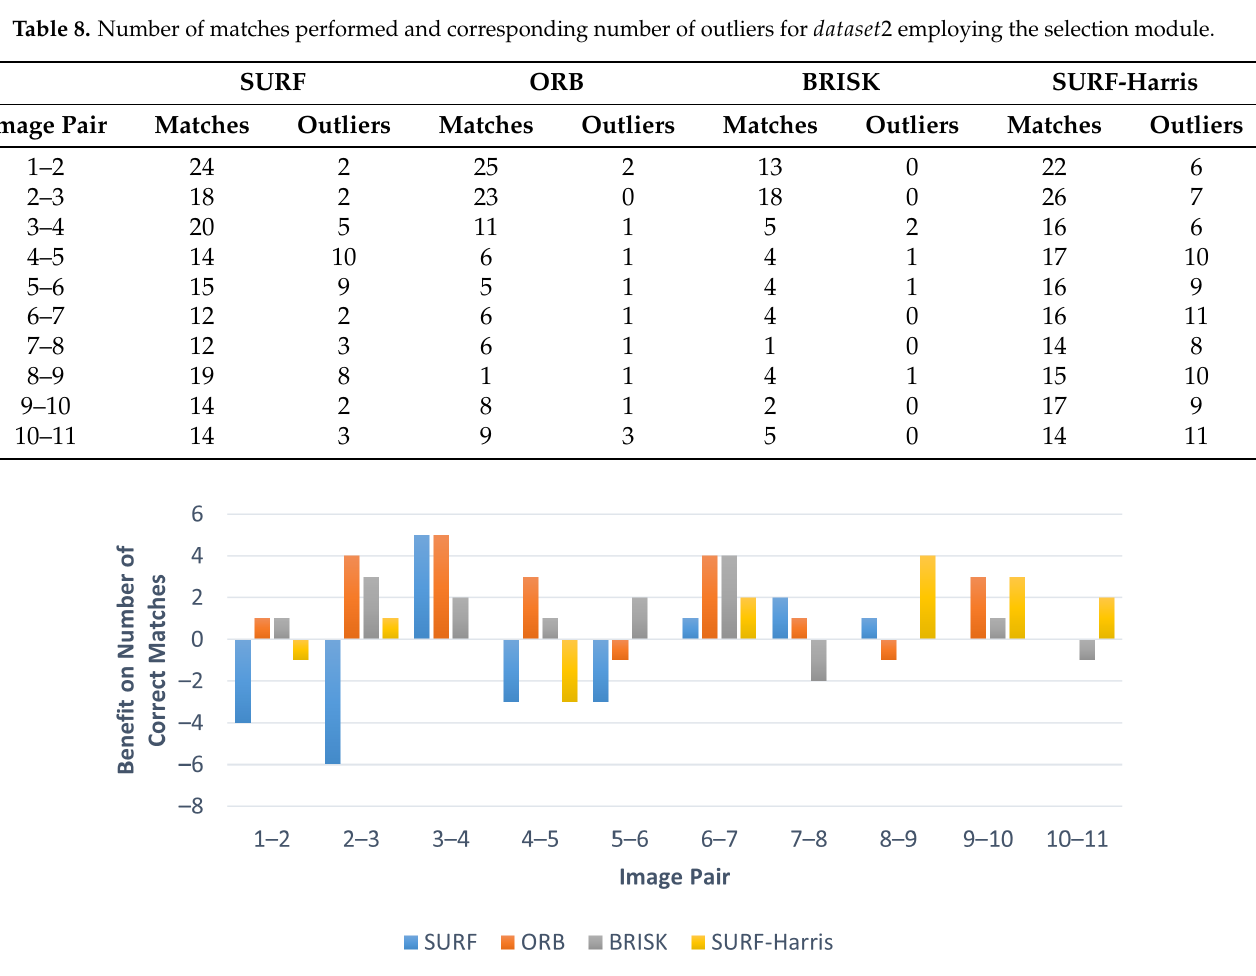
Figure 27. Improvement on the number of correct matches performed for the 50 best interest points for each image pair of dataset 2 through feature